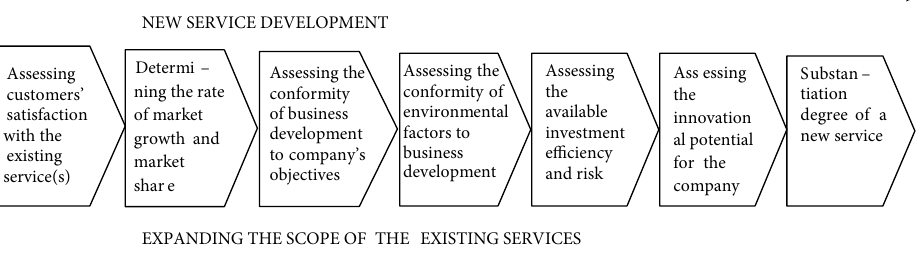
Fig. 1. Process model for determining the purposefulness of new service